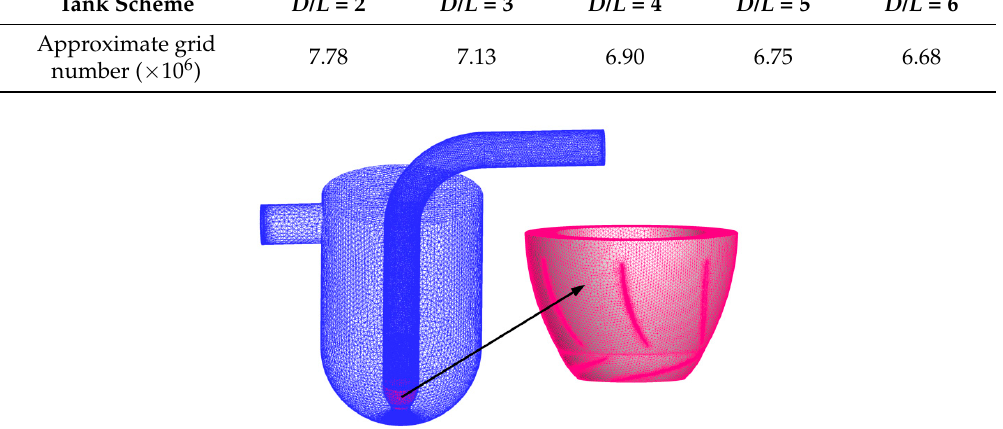
Table 1. Grid numbers adopted in final simulations.